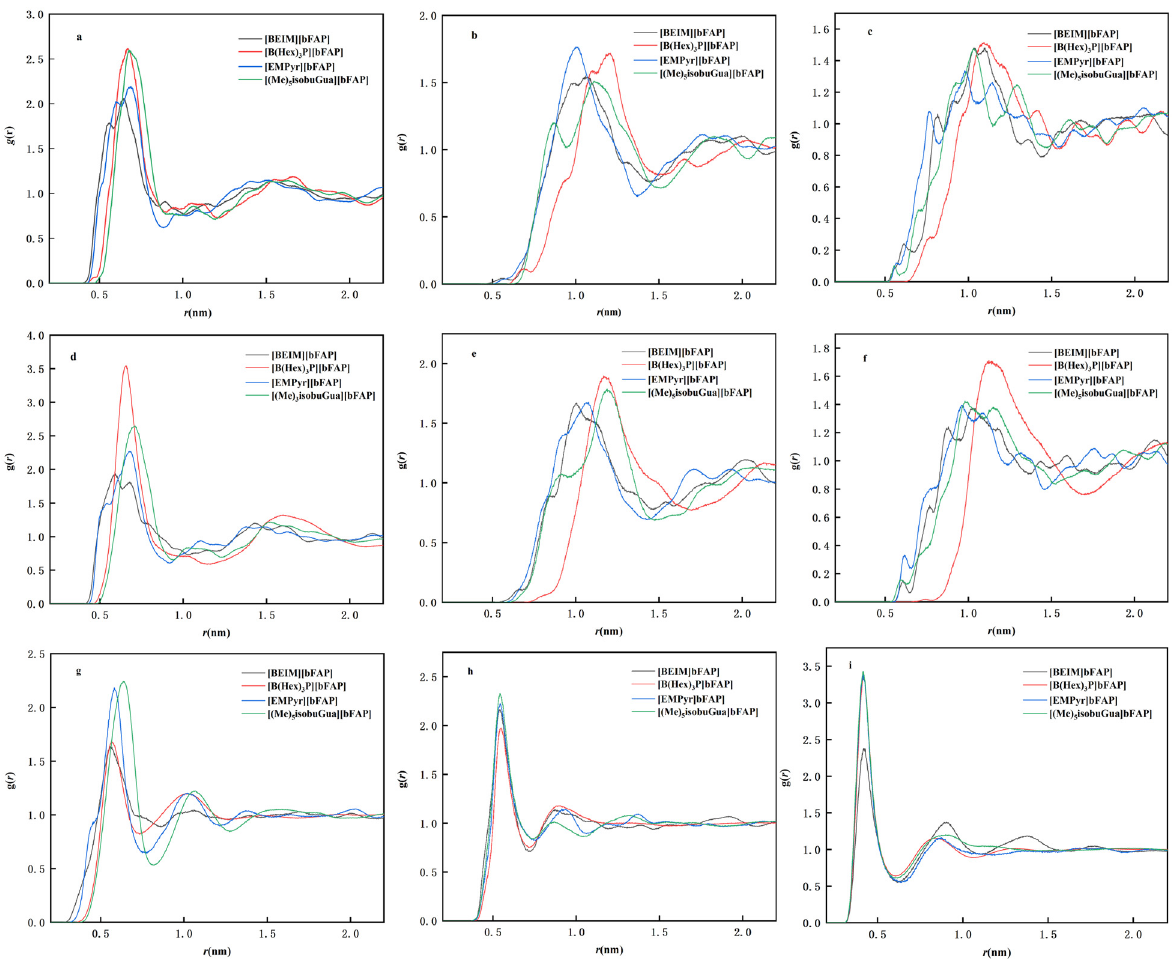
Figure 3: Radial distribution functions in ILs and IL/CO 2 systems at 298 K and 100 kPa: ( a ) cation – anion in IL, ( b ) cation – cation in IL, ( c ) anion – anion in IL, ( d ) cation – anion in IL/CO 2 , ( e ) cation – cation in IL/CO 2 , ( f ) anion – anion in IL/CO 2 , ( g ) CO 2 – cation in IL/CO 2 , ( h ) CO 2 – anion in IL/CO 2 , and ( i ) CO 2 – CO 2 in IL/CO 2 .